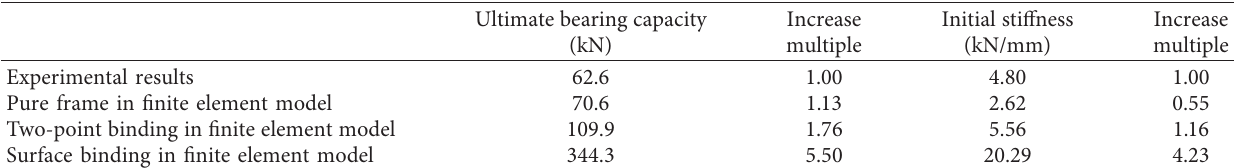
Figure 17: Comparison of load-displacement curve for QX-2. Table 4: Comparison of the ultimate bearing capacity and initial stiffness for QX-2.